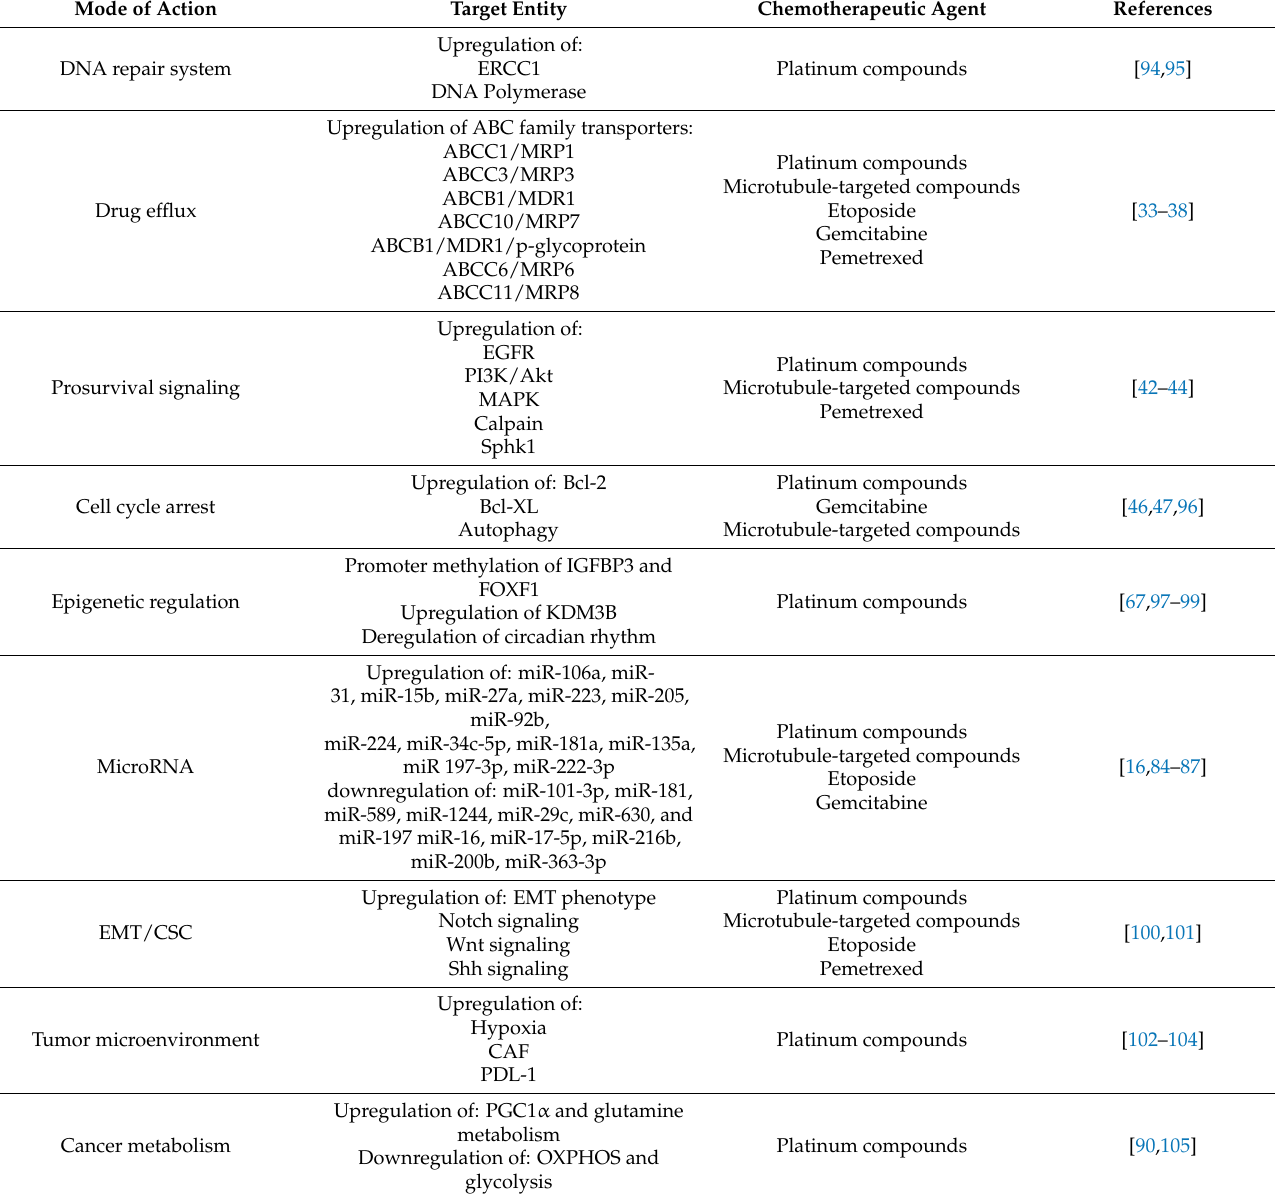
Table 1. Summary of mechanism of chemotherapeutic resistance in lung